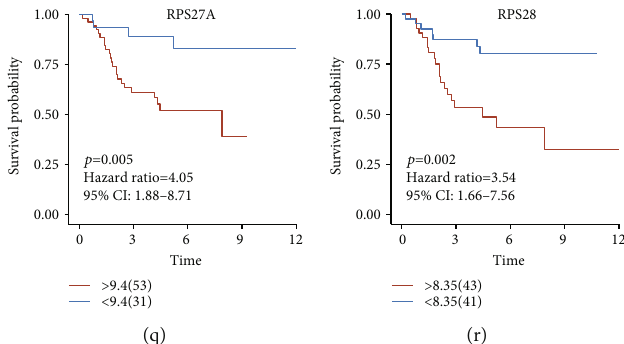
Figure 8: Association of genes in EMT score with osteosarcoma prognosis in the TARGET cohort. (a) – (r) Kaplan-Meier survival analyses for high and low expression subgroups of (a) EEF1B2, (b) EIF4A1, (c) RPL10, (d) RPL11, (e) RPL12, (f) RPL13A, (g) RPL21, (h) RPL34, (i) RPL35A, (j) RPL36, (k) RPL37A, (l) RPS8, (m) RPS9, (n) RPS12, (o) RPS23, (p) RPS24, (q) RPS27A, and (r) RPS28 in the TARGET cohort.